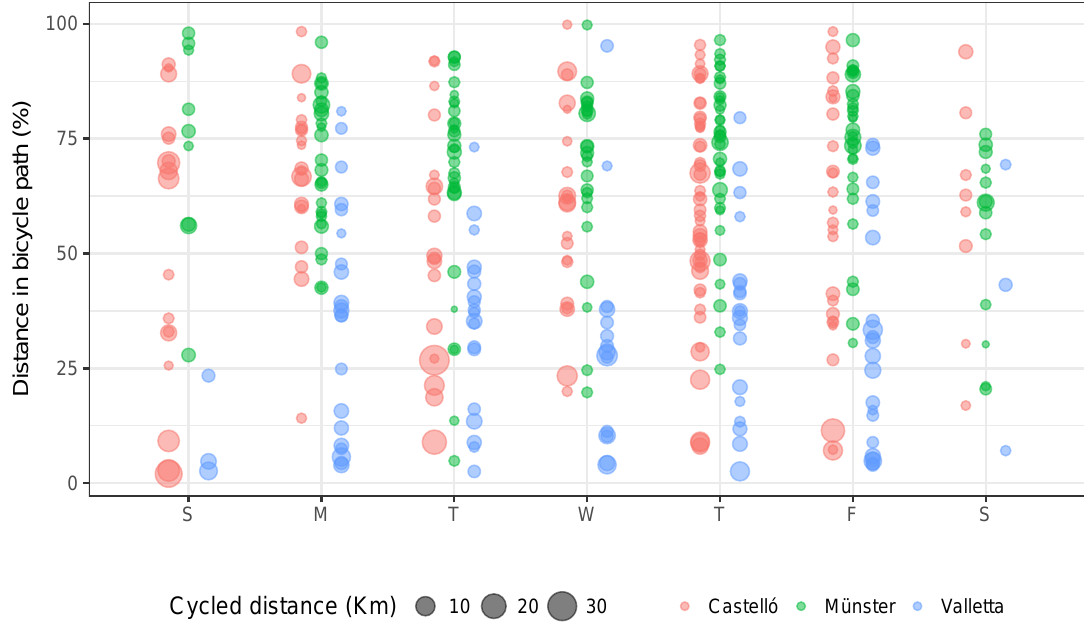
Figure 10. Cycled distance, proportion per trip.